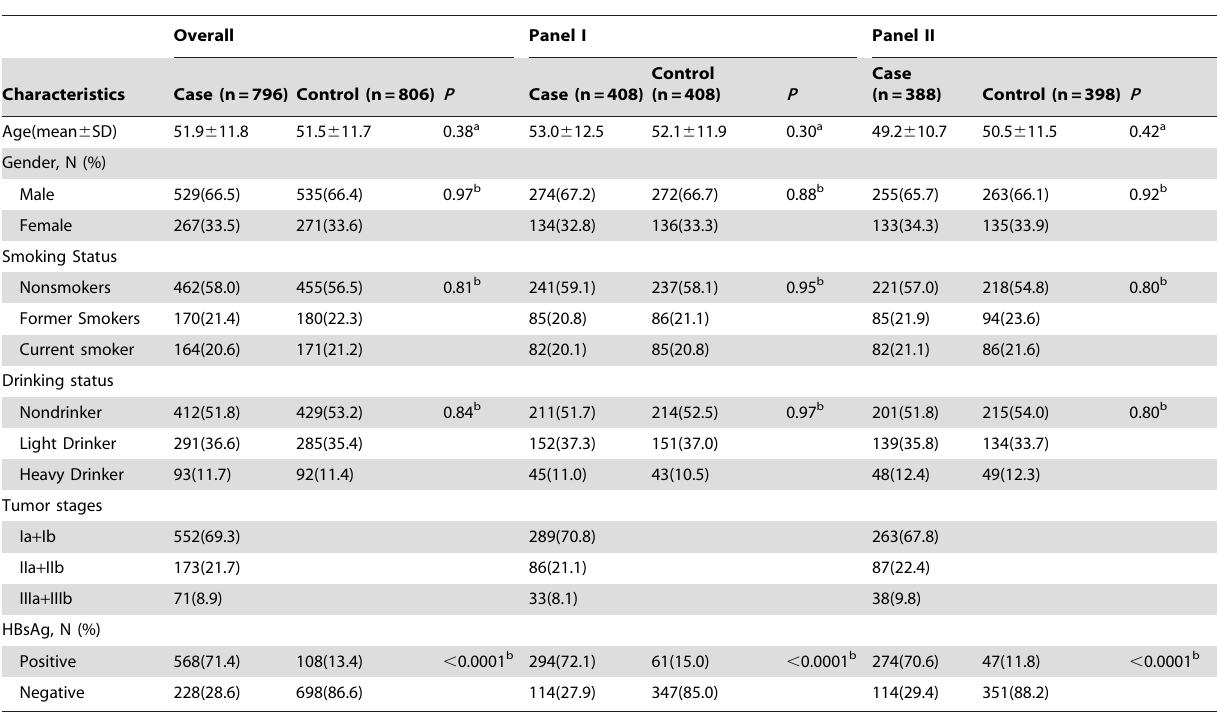
Table 1. Demographic characteristics among HCC cases and controls.